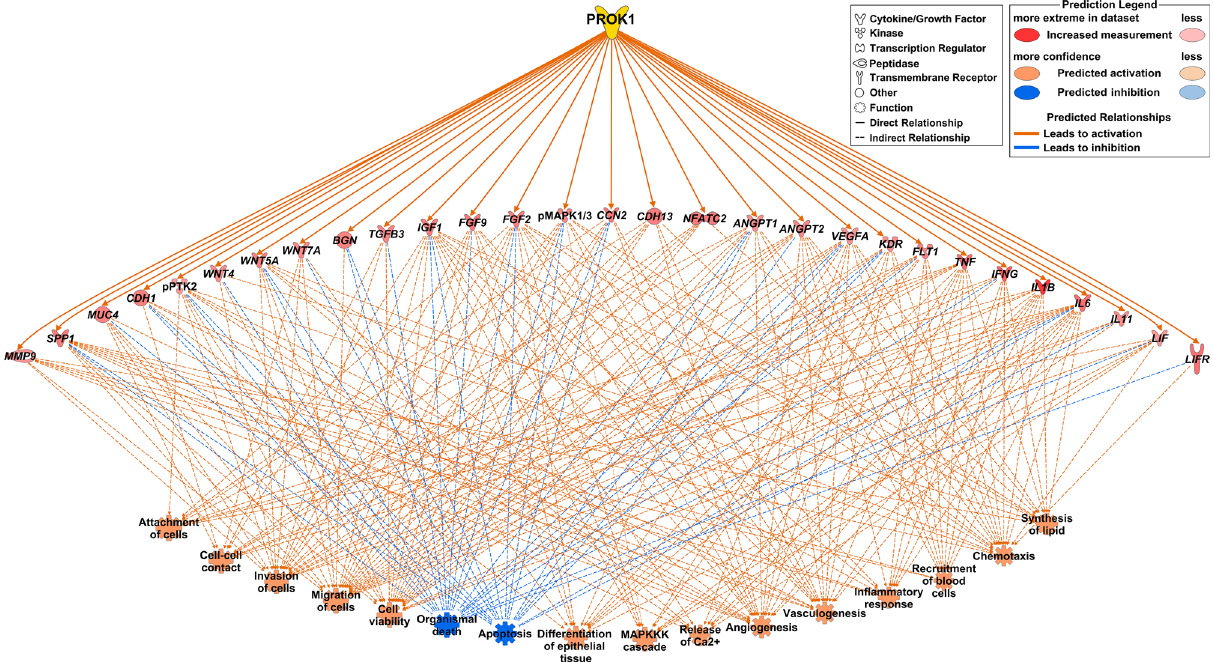
Figure 7. Putative pleiotropic role of prokineticin 1 (PROK1) in the porcine trophoblast during the establishment of pregnancy. The IPA database was used to evaluate the functions of genes up-regulated and proteins activated by PROK1 (vehicle versus PROK1) in the porcine trophoblast collected on days 15 and 20 of pregnancy. The predicted activation is based on an absolute z-score > 2 and the P value of the gene overlap. The icons and color scheme are IPA defaults. Angiopoietin 2 ( ANGPT2 ); cellular communication network factor 2 ( CCN2 ); cadherin 13 ( CDH13 ); fibroblast growth factor 2 ( FGF2 ); fms-related receptor tyrosine kinase 1 ( FLT1 ); kinase insert domain receptor ( KDR ); nuclear factor of activated T cells 2 ( NFATC2 ); vascular endothelial growth factor A ( VEGFA ); phosphorylated mitogen-activated protein kinase 1/3 (pMAPK1/3); phosphorylated protein tyrosine kinase 2 (pPTK2); interferon gamma ( IFNG ); interleukin 1 beta ( IL1B ); interleukin 6 ( IL6 ); interleukin 11 ( IL11 ); LIF interleukin 6 family cytokine ( LIF ); LIF receptor subunit alpha ( LIFR ); tumor necrosis factor ( TNF ); biglycan ( BGN ); cadherin 1 ( CDH1 ); fibroblast growth factor 9 ( FGF9 ); insulin-like growth factor 1 ( IGF1 ); matrix metallopeptidase 9 ( MMP9 ); mucin 4 ( MUC4 ); secreted phosphoprotein 1 ( SPP1 ); transforming growth factor beta 3 ( TGFB3 ); Wnt family member 4 ( WNT4 ); Wnt family member 5A ( WNT5A ); Wnt family member 7A ( WNT7A